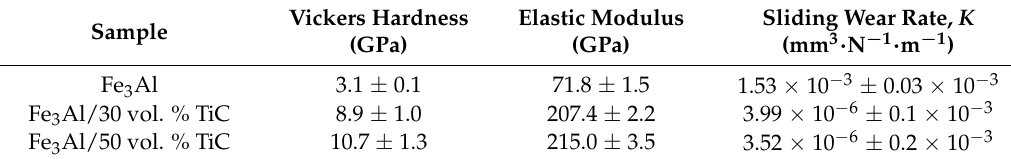
Table 2. Hardness, elastic modulus, and sliding wear rates of the